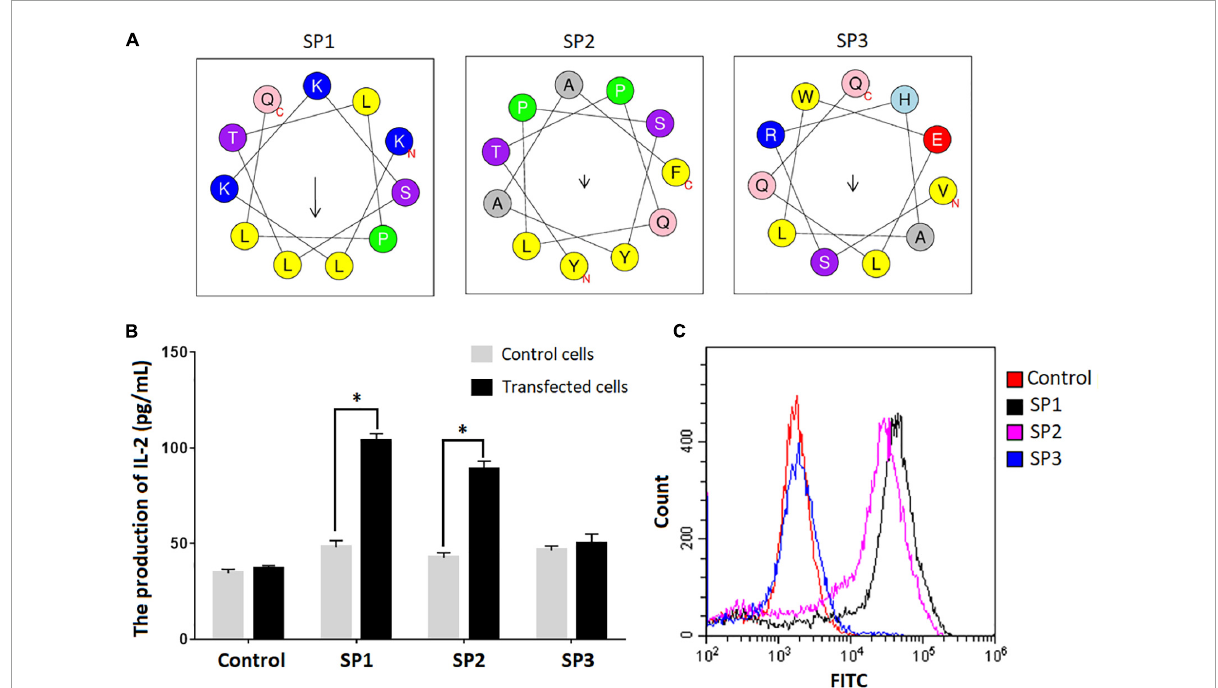
FIGURE2 Confirmation of peptide binding to SARS-CoV-2 specific γδ TCR transfected cells. (A) Spiral structure of three identified peptides predicted by bioinformatics tools on the Heliquest website (http://heliquest.ipmc.cnrs.fr/?tdsourcetag=s_pcqq_aiomsg). (B) IL-2 secretion after stimulation by the identified peptides in SARS-CoV-2 specific γδ TCR transfected cells. The three peptides and control peptide were separately co-cultured with SARS-CoV-2 specific γδ TCR transfected cells and control cells for 24 h. IL-2 production in the supernatant of the cell culture medium was detected by ELISA. Data was presented as mean ± SD from triplicate experiments. (C) The results of FACS analysis revealed the affinity between identified peptides and SARS-CoV-2 specific γδ TCR transfected cells. The identified peptides and control peptides had been conjugated with FITC (10 µ g) and were separately co-cultured with SARS-CoV-2-specific γδ TCR transfected cells. The results showed that SP1 (76.3%) and SP2 (58.9%) could bind more effectively to the transfected cells than SP3 (2.78%). The results are representative of three independent experiments. ∗ Denotes p <